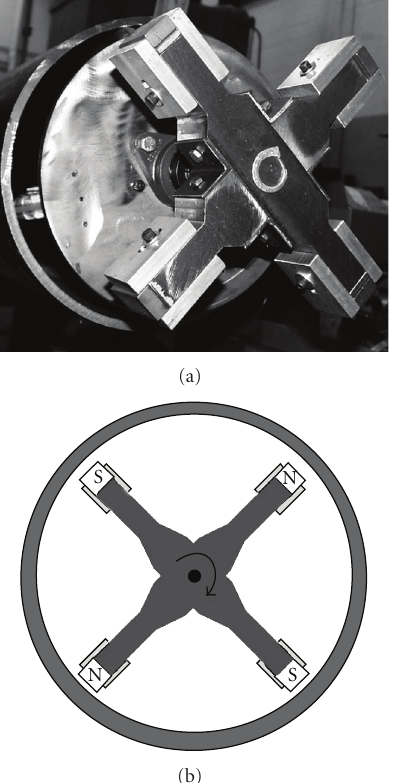
Figure 3: Photo of the eddy current system developed by Nestleroth and Davis (2007) [30]. Courtesy of